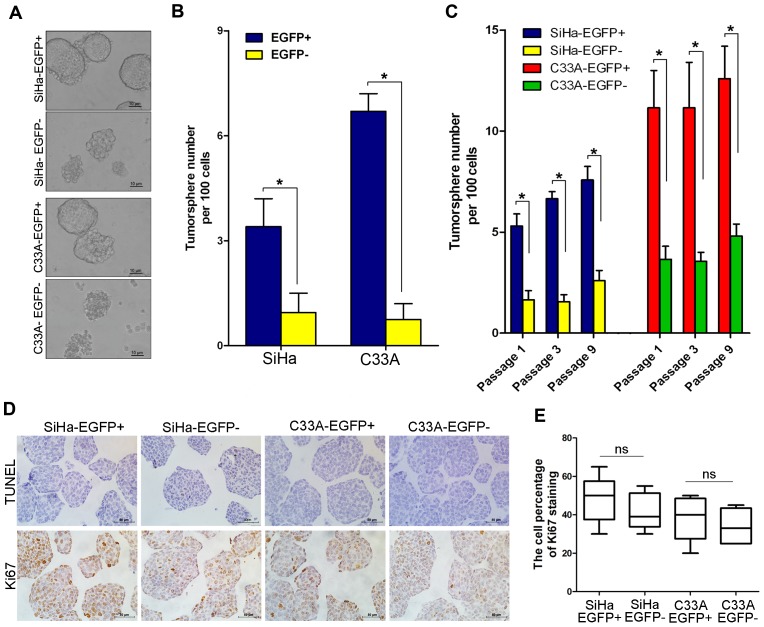
EGFP-positive cells exhibit a greater capacity for self-renewal than EGFP-negative cells.(A, B) Tumorsphere formation assay photographs and the number of tumorspheres formed by SiHa and C33A cells in low-density cultures. (C) Tumorsphere formation assay of EGFP+ cells during passaged culture following single-cell sorting by FACS. The apoptosis/proliferation cell rate was evaluated by Tunel assays and Ki67 staining in xenograft (D and E) of EGFP+ and EGFP- cells. Bars = SE. *, p<0.05. ns, p>0.05.